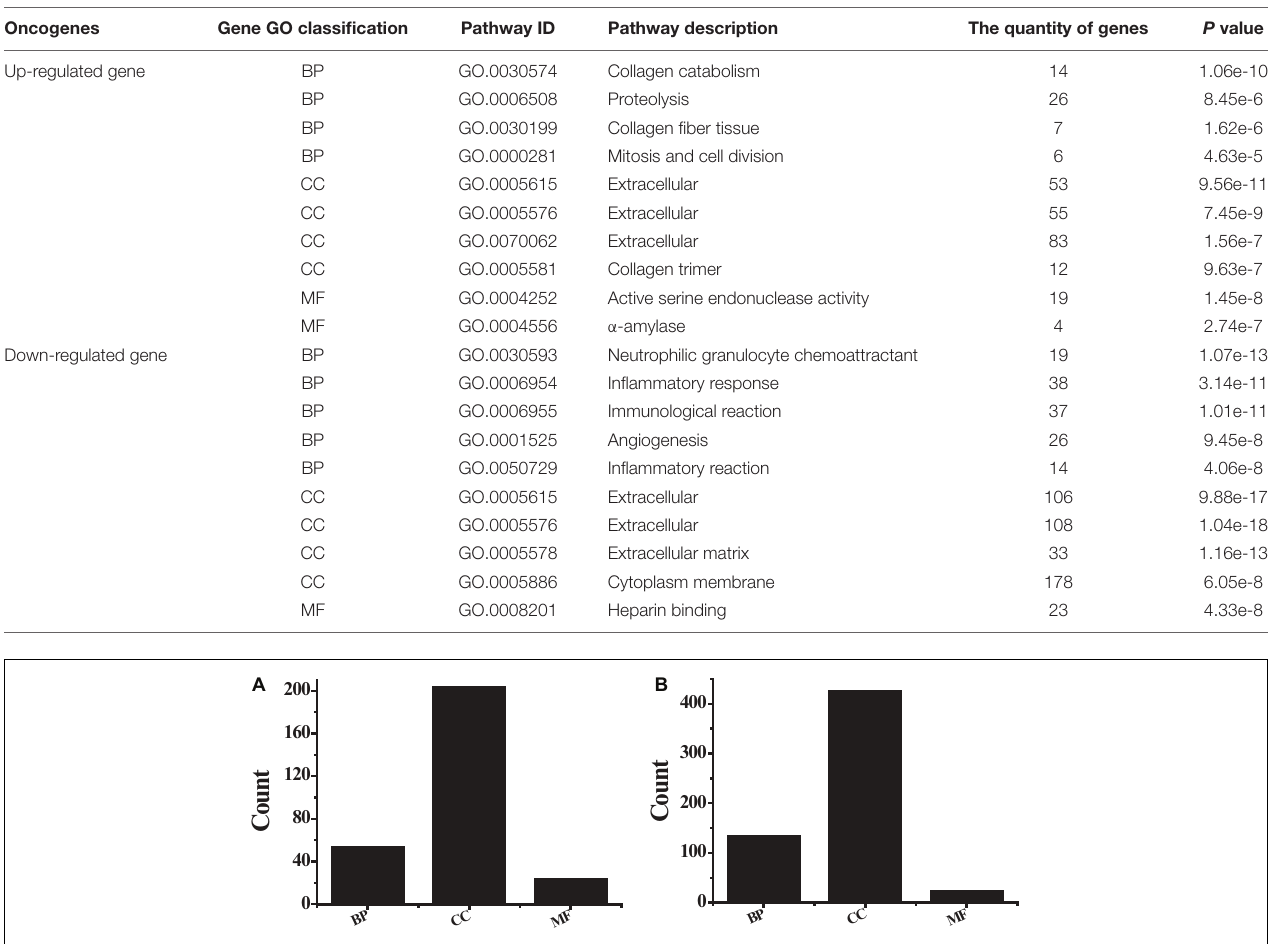
FIGURE 5 | The GO analysis results (A) the first 10 up-regulated genes; (B) the first 10 down-regulated